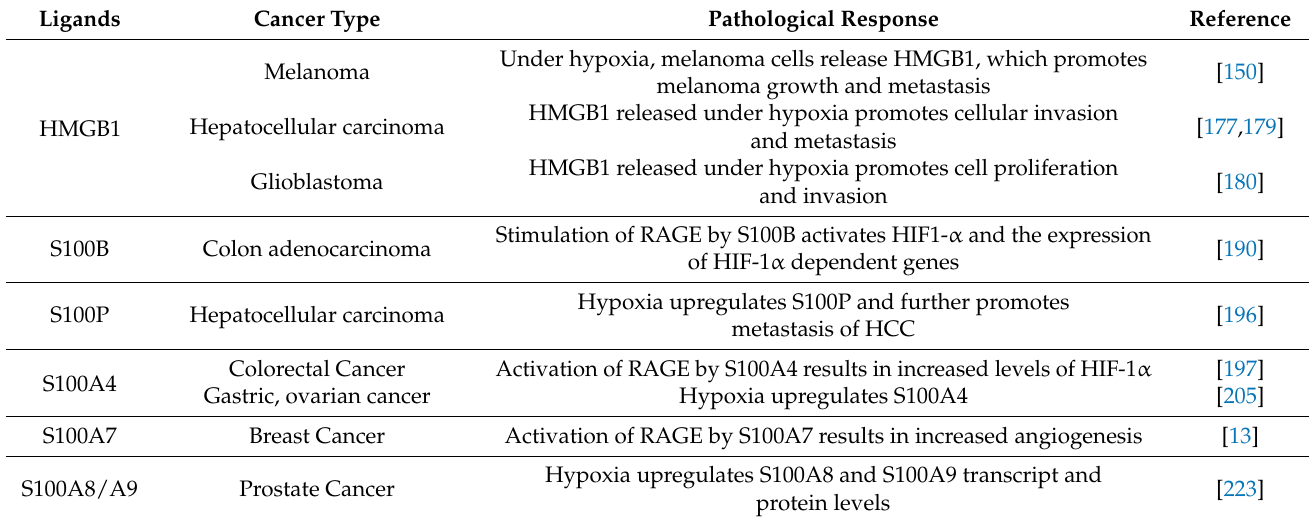
Table 1. Effect of hypoxia on RAGE ligand levels or RAGE/ligand